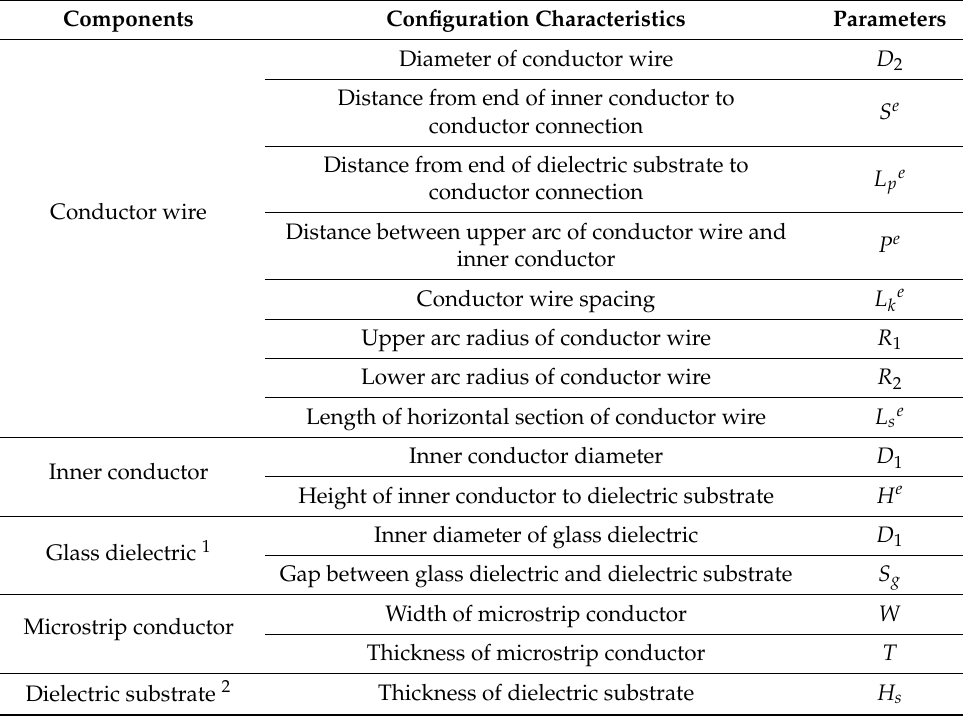
Table 1. Configuration parameters and dielectric properties of FCWI.